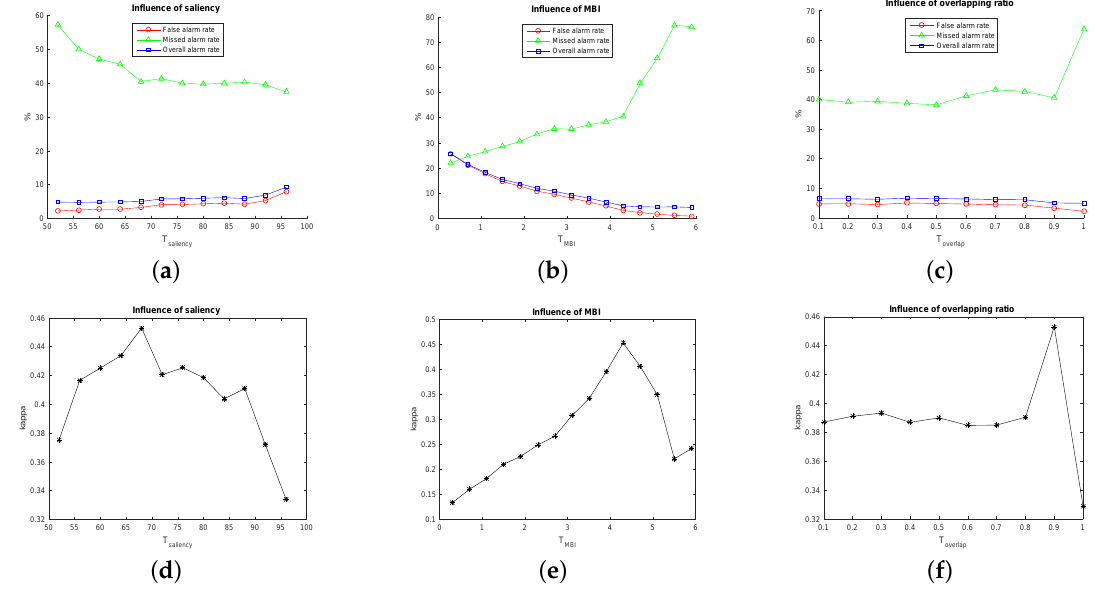
Figure 6. Sensitivity delineation of the parameters for the second image pairs. ( a ) Influence of saliency on FAR, MAR and OAR; ( b ) influence of MBI on FAR, MAR and OAR; ( c ) influence of overlapping ratio on FAR, MAR and OAR; ( d ) influence of saliency on kappa ; ( e ) influence of MBI on kappa ; ( f ) influence of overlapping ratio on kappa